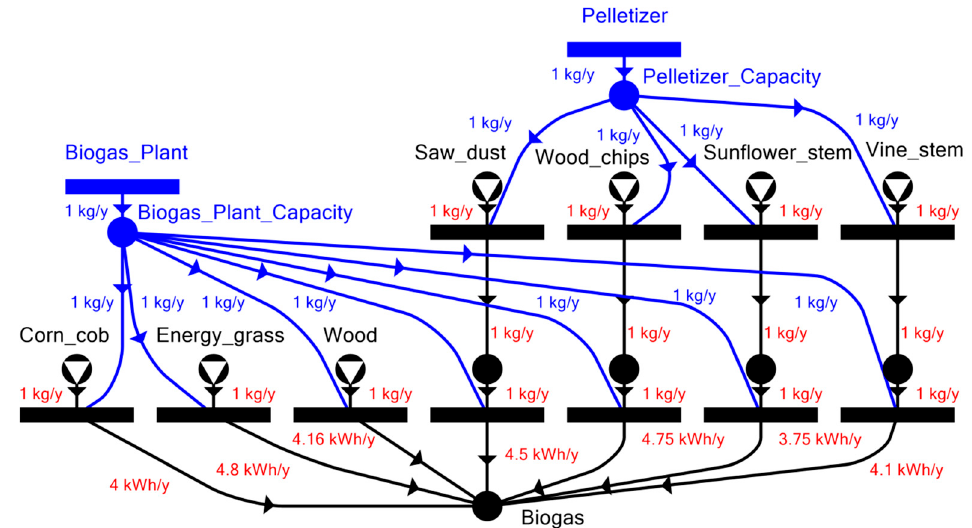
Figure 8. Modeling of the biomass supply part of the process network. With this approach, biogas plant and pelletizer capacities are expressed in terms of total input masses.